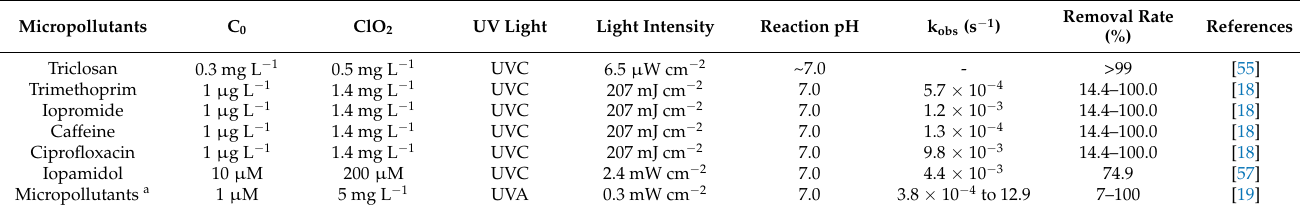
Table 3. SummaryofresearchstudyingtheremovalofmicropollutantsbytheUV-activated ClO 2 oxidation. Micropollutants C